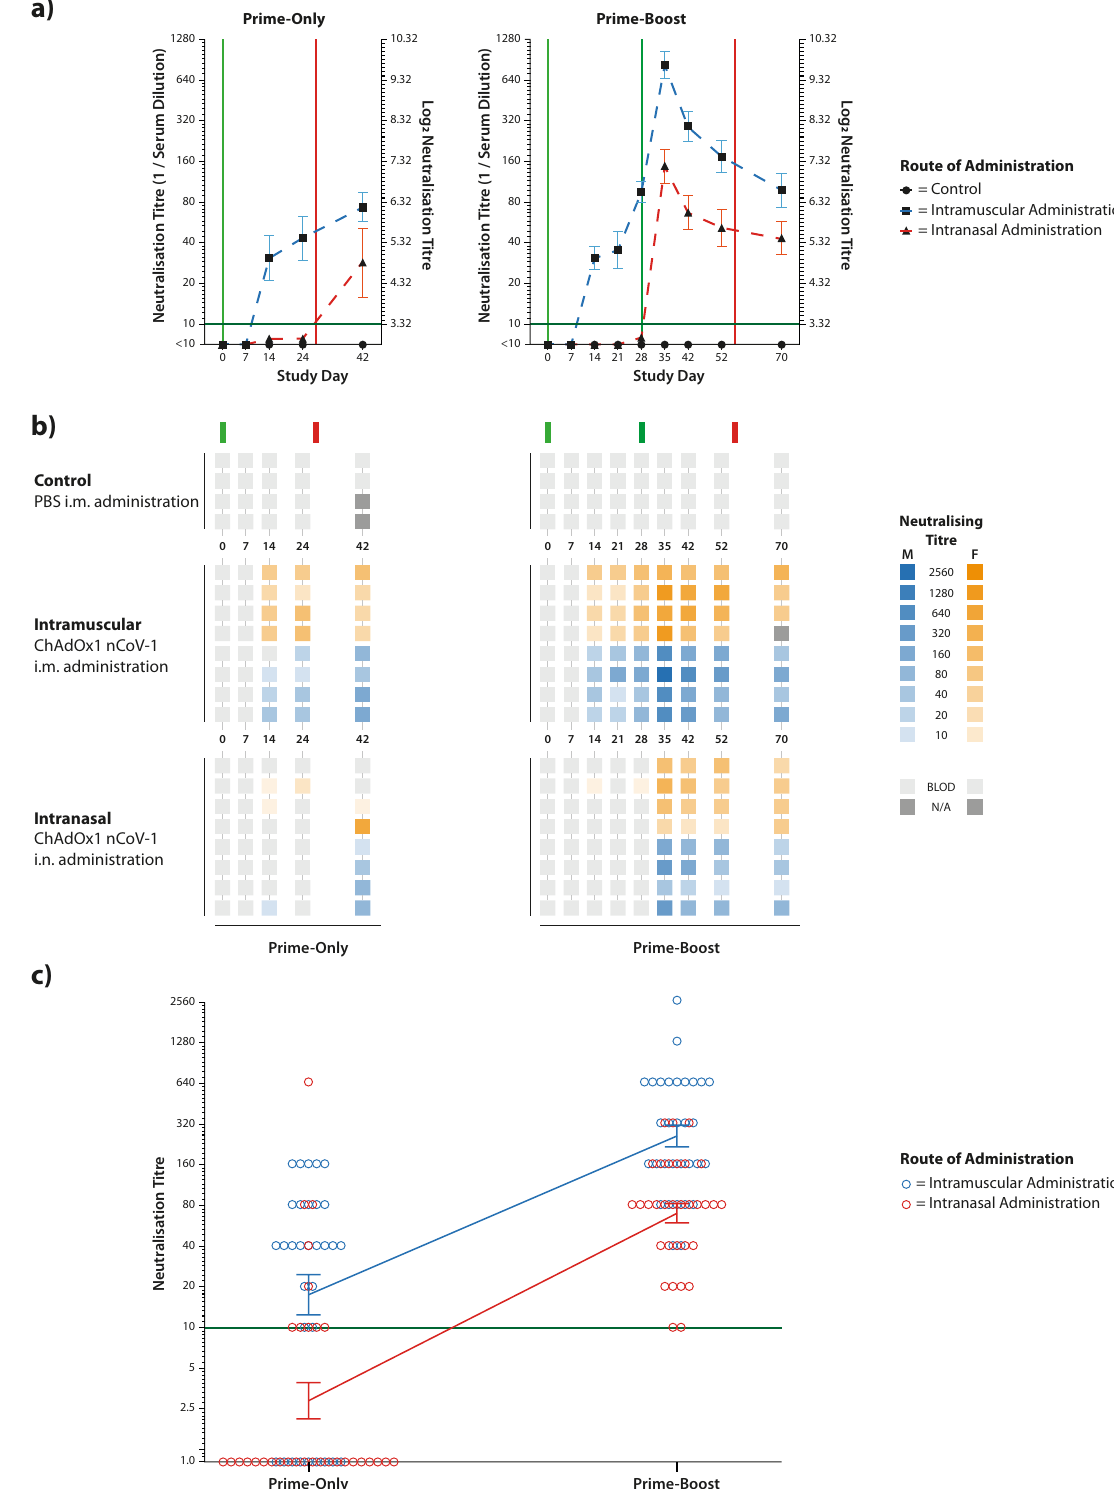
vaccine and the SARS-CoV-2 challenge inoculum 20 . The investiga- tion found that the ChAdOx1 nCoV-19 vaccine candidate was not implicated in the unexpected reaction, and the observed reaction did not affect the study outcomes for the remaining ferrets.